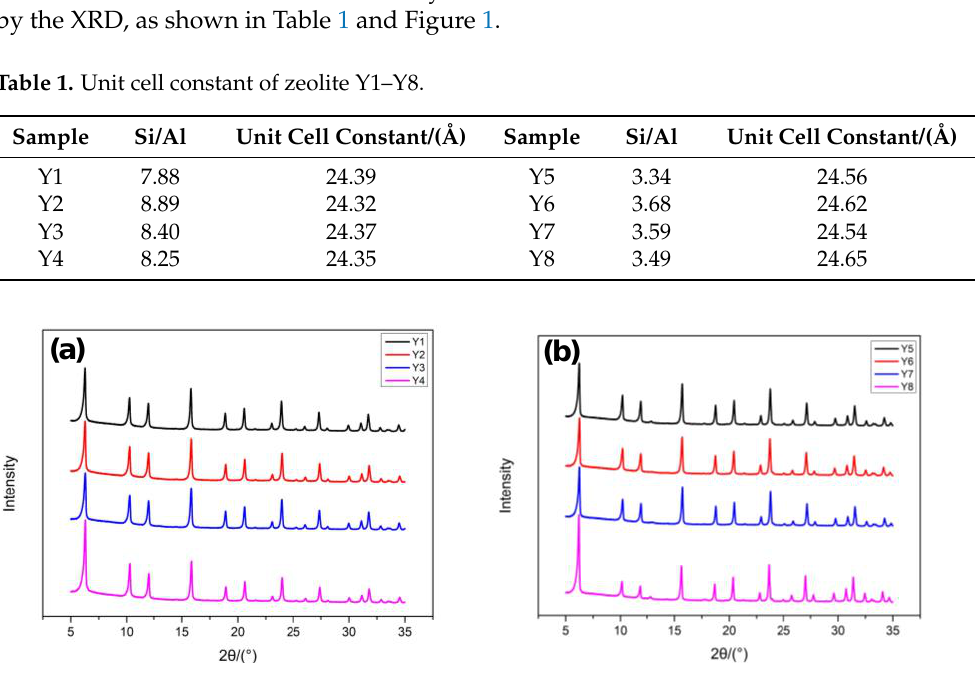
Figure 1. ( a ) XRD patterns of Y1 – Y4 and ( b ) XRD patterns of Y5 – Y8.